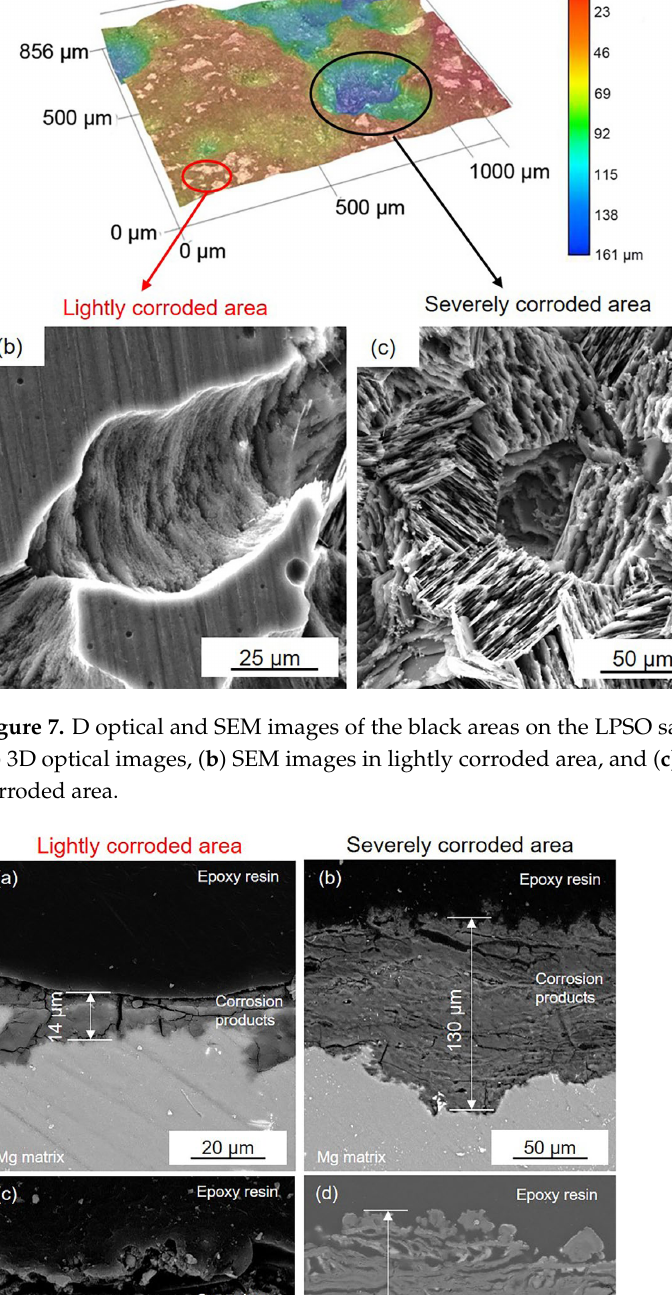
Figure 6. D optical and SEM images of the black areas on the HOMO samples after 24 h immersion: ( a ) 3D optical images, ( b ) SEM images in lightly corroded area, and ( c ) SEM images in the severely corroded area.